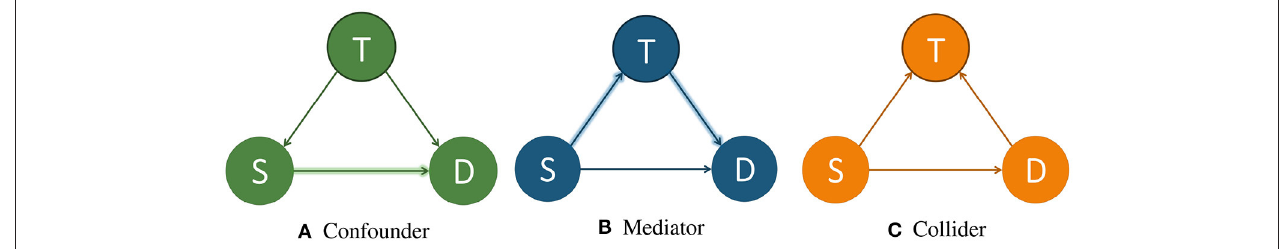
FIGURE 1 | Example causal models showing T as a confounder, mediator, and collider. T , treatment; S , severeness; D , survival. In (A) , T is a confounder since it impacts both the input variable S and the output variable D . In (B) , T is a mediator since it lies between the input variable S and the output variable D in one possible path. In (C) , T is a collider since it is influenced by both S and D . An example of a direct path is shown in (A) by the arrow highlighted in green going from S to D . An example of an indirect path is shown in (B) by the arrows highlighted in blue traveling from S to D through T